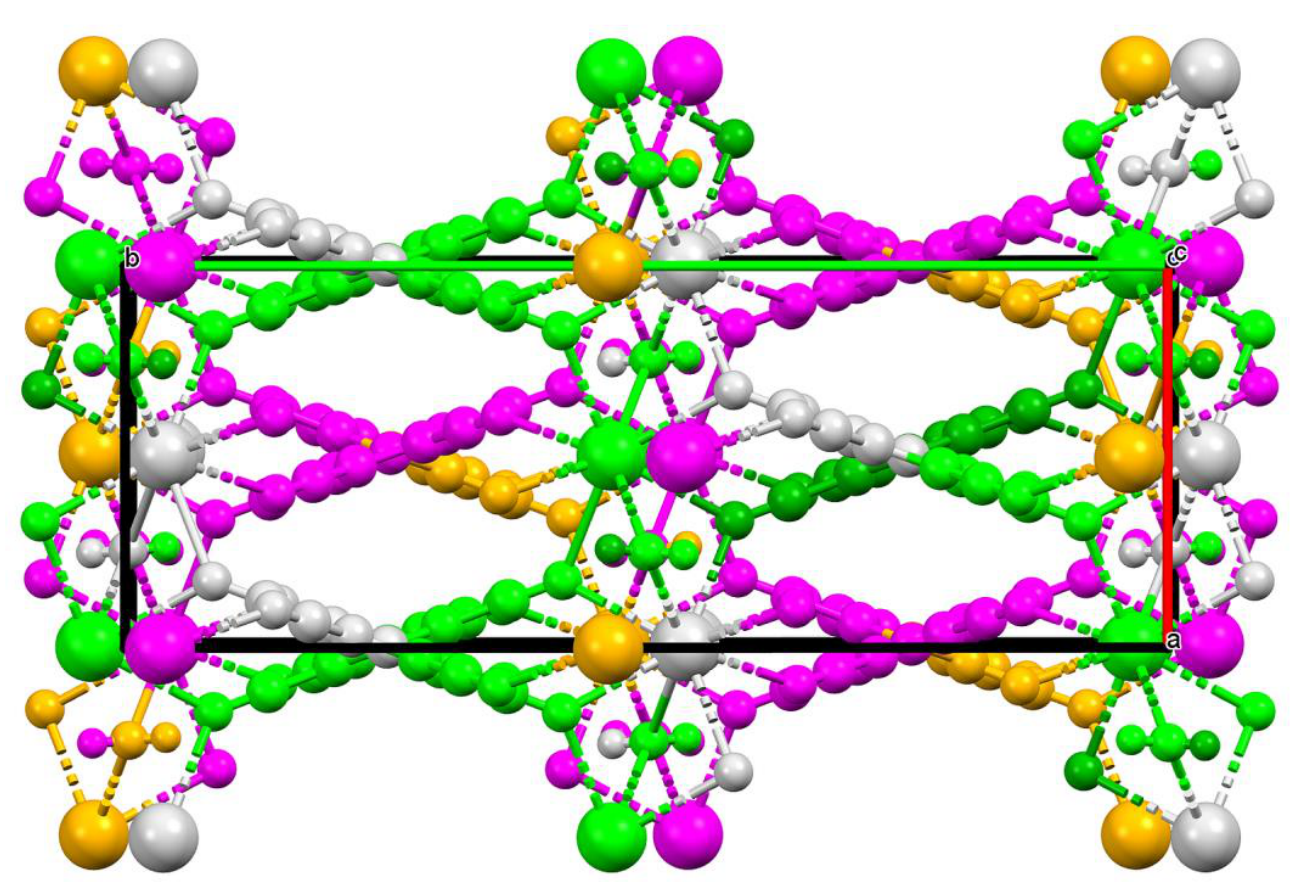
Figure 15. Packing plot of compound 6a , watched along the crystallographic c axis. Color coding “by symmetry operation” (default settings of MERCURY ).